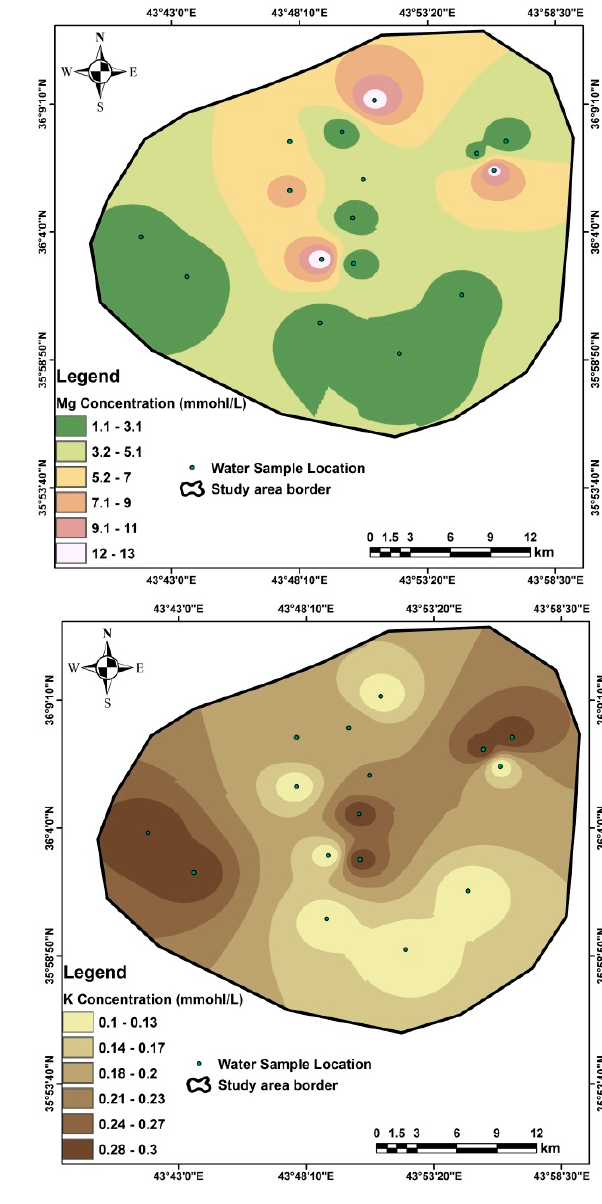
Figure A2. Special distribution of the cations in the study area.